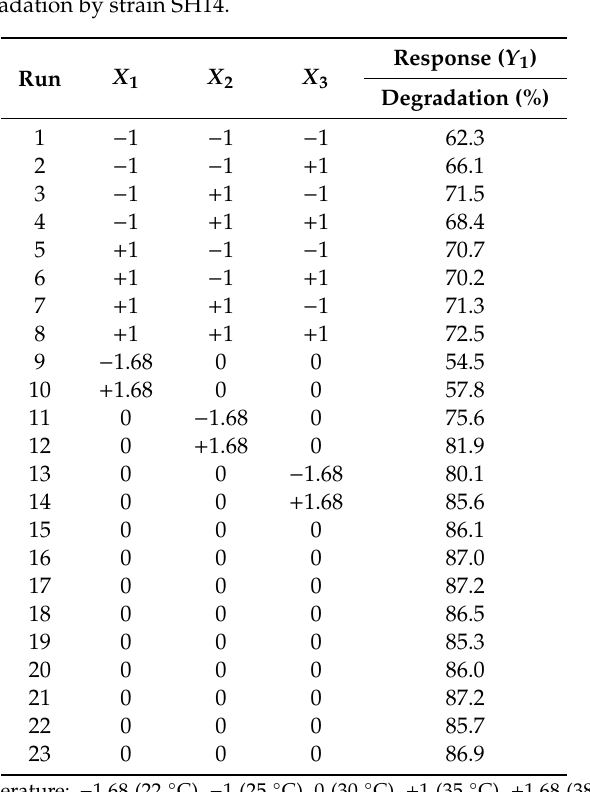
Figure 3. Biodegradation of azoxystrobin(50 μg·mL −1 ) during the growth of strain SH14. Symbol: □ , azoxystrobin control; ■ , azoxystrobin degradation by strain SH14; ▲ , cell growth. Data represent mean values of three replicates with standard deviation. Table 2. Central composite rotatable design (CCRD) matrix and the response of the dependent variable for azoxystrobin degradation by strain